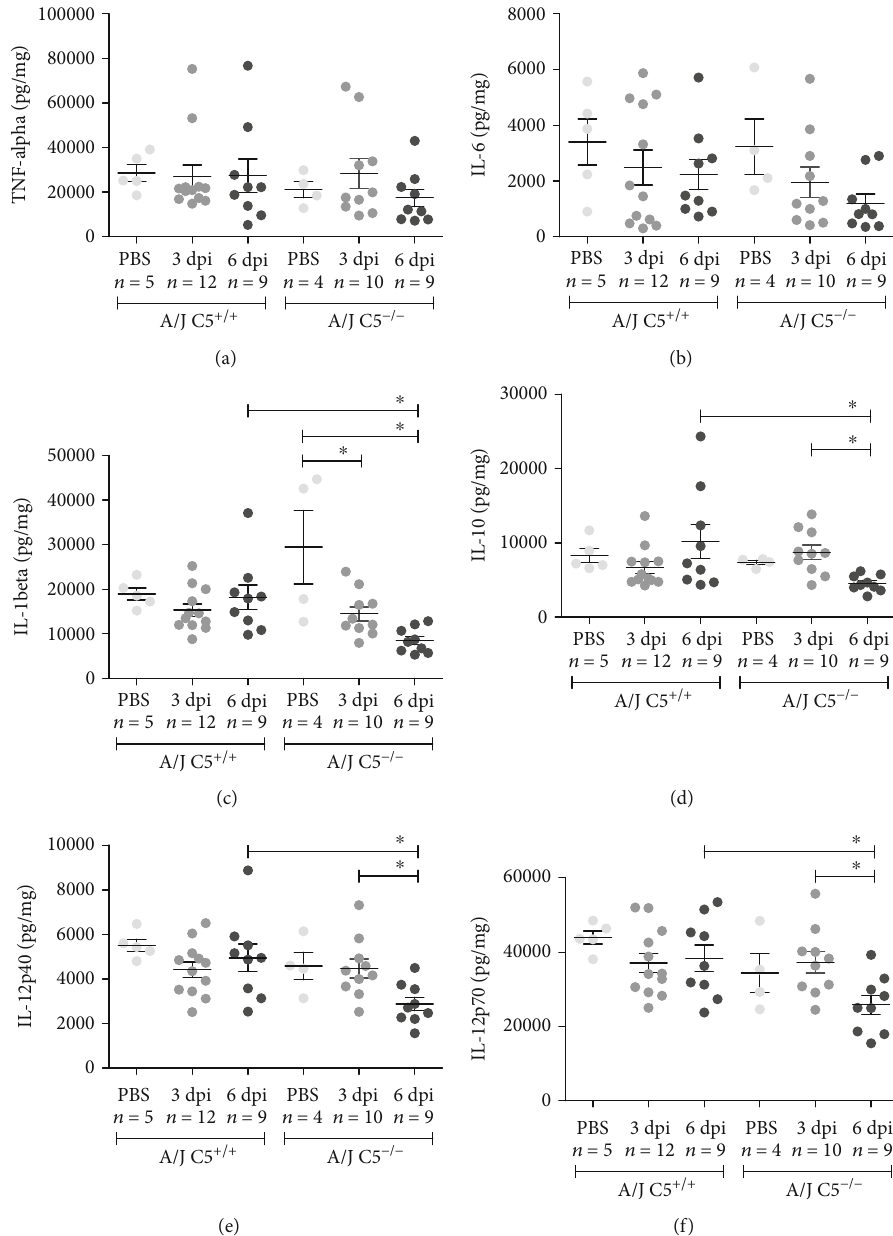
Figure 4: Liver concentrations of pro- and anti-in fl ammatory cytokines during early infection by LPF. A/J C5 +/+ and A/J C5 -/- mice were inoculated i/p with 1 : 5 × 10 8 LPF or PBS and then euthanized on the third or the sixth days. The concentrations of several cytokines were analyzed in the liver extracts by ELISA, using the same protein concentration in each sample. Signi fi cant di ff erences are indicated as ∗ when p < 0 : 05 . dpi: days